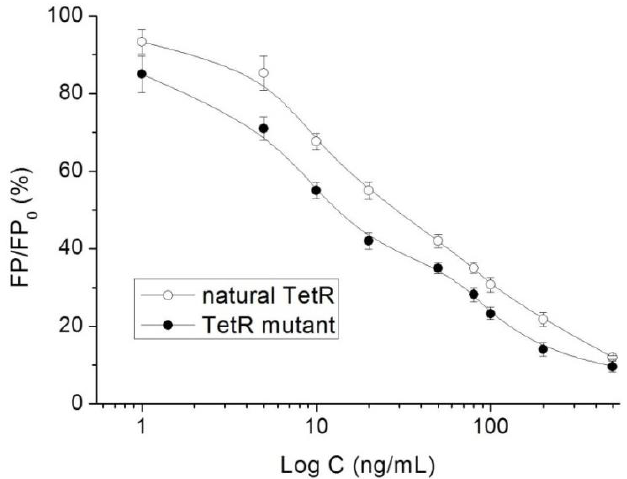
Figure 5. CompetitivecurvesofDMC when using the natural TetR and the mutant ( n =5).